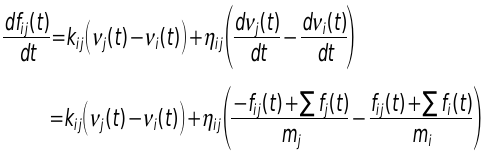
From Equation (28) and Equation (30), it is found